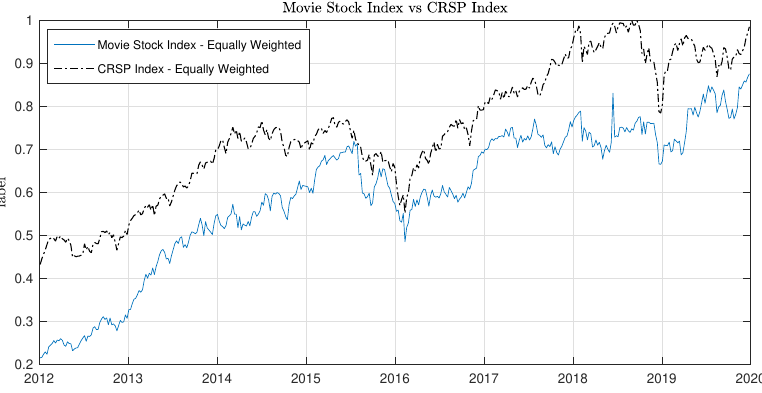
Figure 18. Comparison between the equally weighted stock index formed with produc- tion/distribution public companies and the equally weighted CRSP